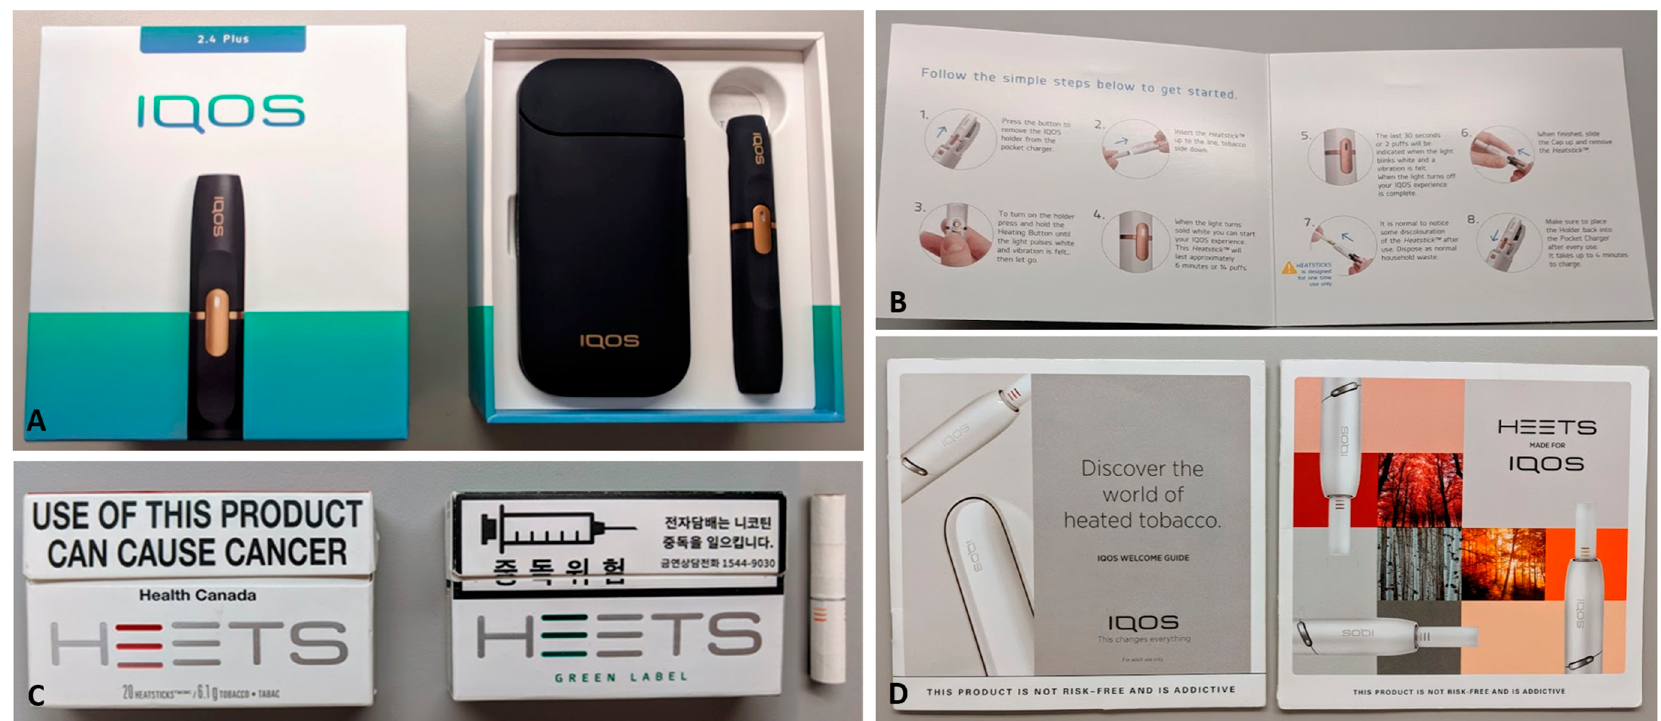
Figure 1. IQOS products and marketing materials used in the study. ( A ) IQOS 2.4 device (same as the one available in the US at time of publication): charger (left) and holder (right) in the box; ( B ) IQOS Quick Start Guide, ( C ) Tobacco sticks (HEETS; Left: Canada, “Red”; Right: Korea, “Green Label”, warning label reads “danger of addiction” and “e-cigarettes cause nicotine addiction” and lists a Quitline number); ( D ) other marketing materials (Left: IQOS device brochure; Right: HEETS brochure). The device brochure includes claims of “cutting edge technology”, “a better choice”, “heat not burn”, and “no smoke” (e.g., “no smoke: IQOS leaves no smoke smell on you and around you”). The HEETS brochure describes five different blends (e.g., “Elm” and “Birch”) using metrics on “aroma”, “body”, and “taste” and promotes “finding your perfect flavor”. Menthol HEETS were acquired in Korea; all other products were acquired in Vancouver, BC, Canada.